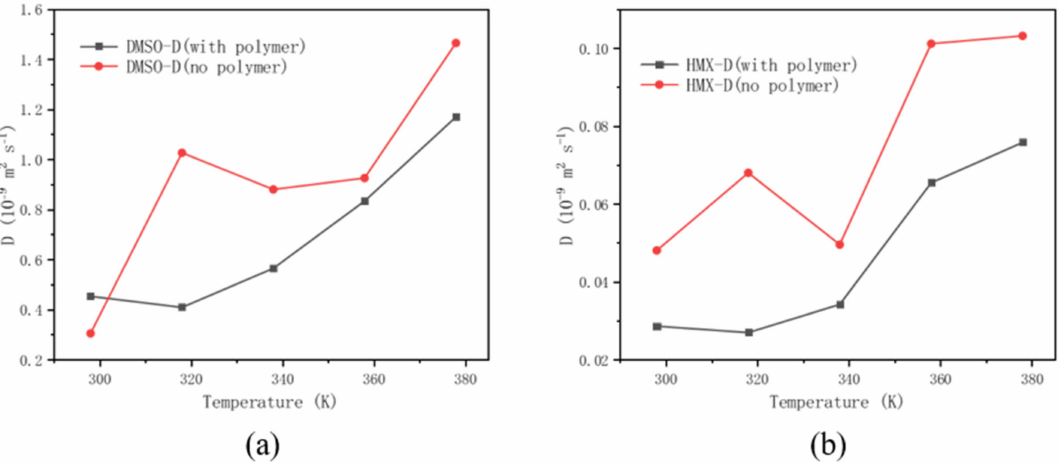
Figure 12. The variation of D of DMSO and β -HMX in the crystallization system with and without PVA at different temperatures. ( a ) The changing trend of D of DMSO with temperature in the presence of PVA or not, and ( b ) The changing trend of D of HMX with temperature in the presence of PVA or